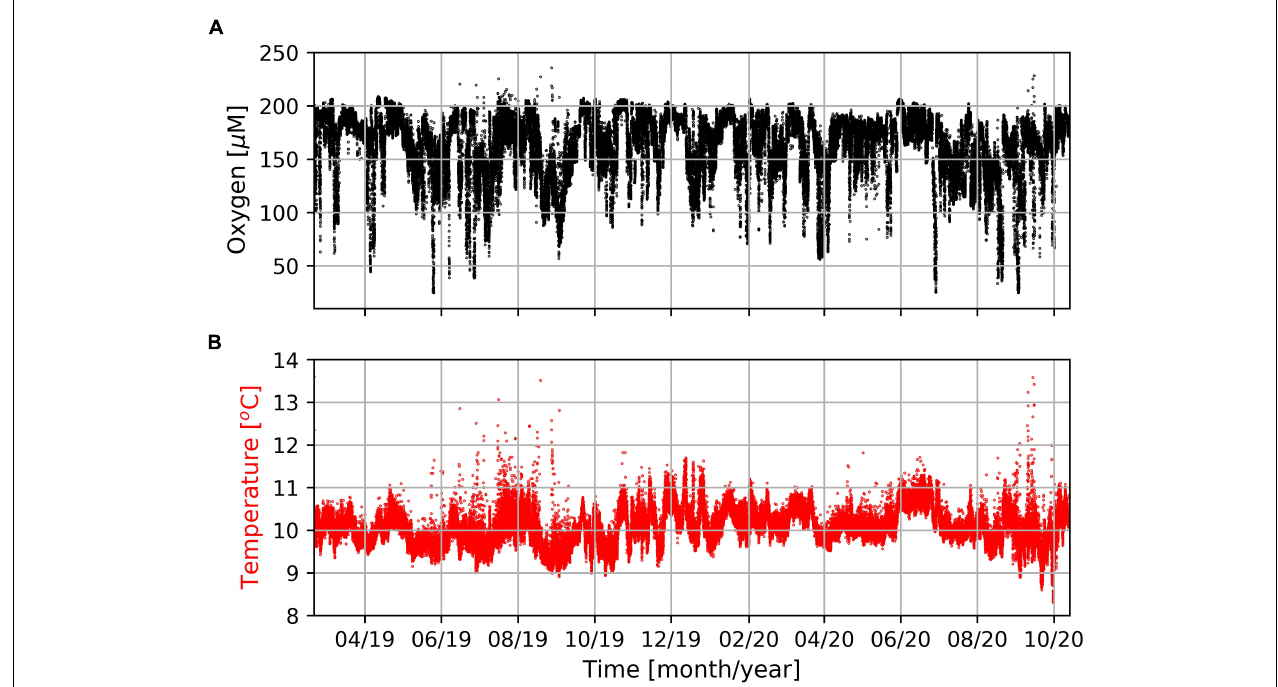
FIGURE 4 | Concentrations of dissolved oxygen (A) and seawater temperature (B) measured by the MDO sensor at the mooring site ( Figure 1 ) in a water-depth of 96 m during the entire period of observation.